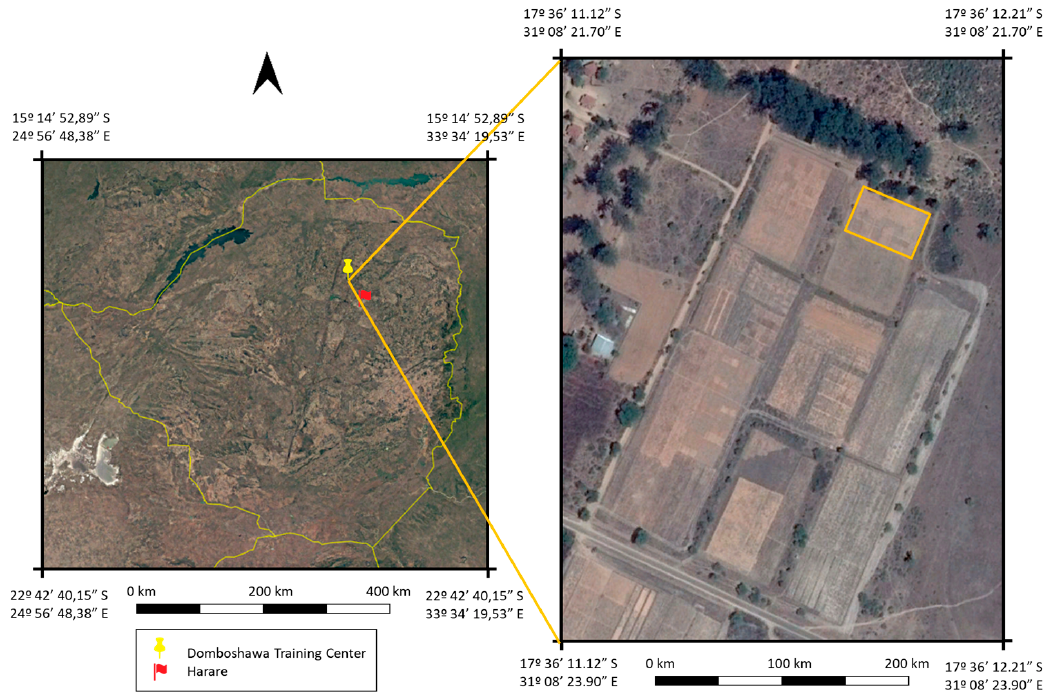
Figure 1. Landsat satellite ( left ) and CNES Airbus ( right ) images of the study area acquired using Google Earth Pro. The photographs are from the 31st of December 2015. The image on the left shows the location of the Domboshawa Training Center in Zimbabwe. The image on the right shows the field site.